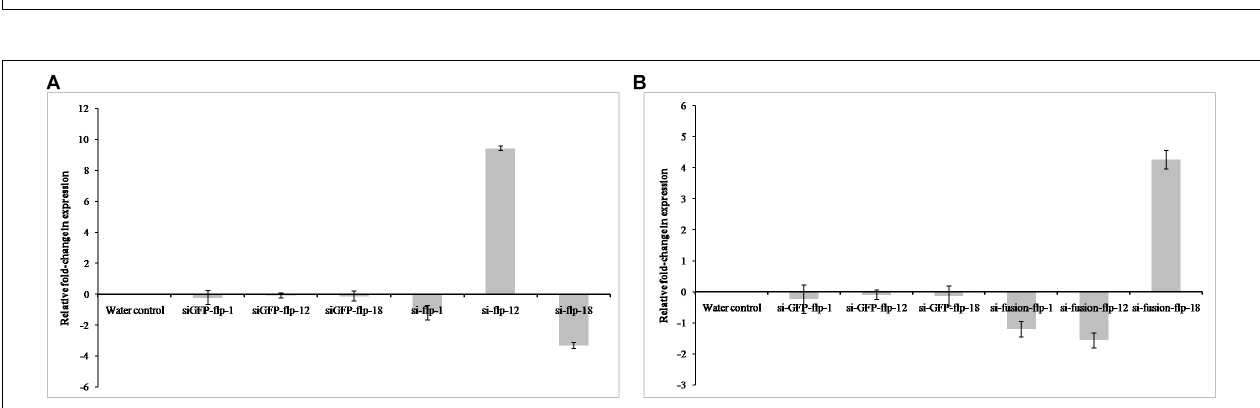
FIGURE 3 | Quantification of target gene transcripts in dsRNA treated J2s of M. incognita . The relative expression levels of target mRNA were quantified by qRT-PCR in M. incognita silenced for (A) Mi-flp1, Mi-flp12, and Mi-flp18 , (B) FLPs-fusion gene, compared to non-native GFP control and water control. 18s rRNA was used as a reference gene and fold-change was calculated using 2 - (cid:49) (cid:49) CT method. Each bar represents the mean ± SE of n = 3 ( P < 0.05).